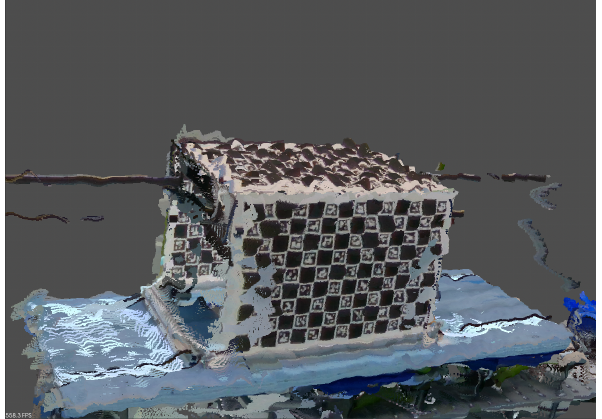
Figure 5. Charuco board with noise and artefacts due to the repetitive